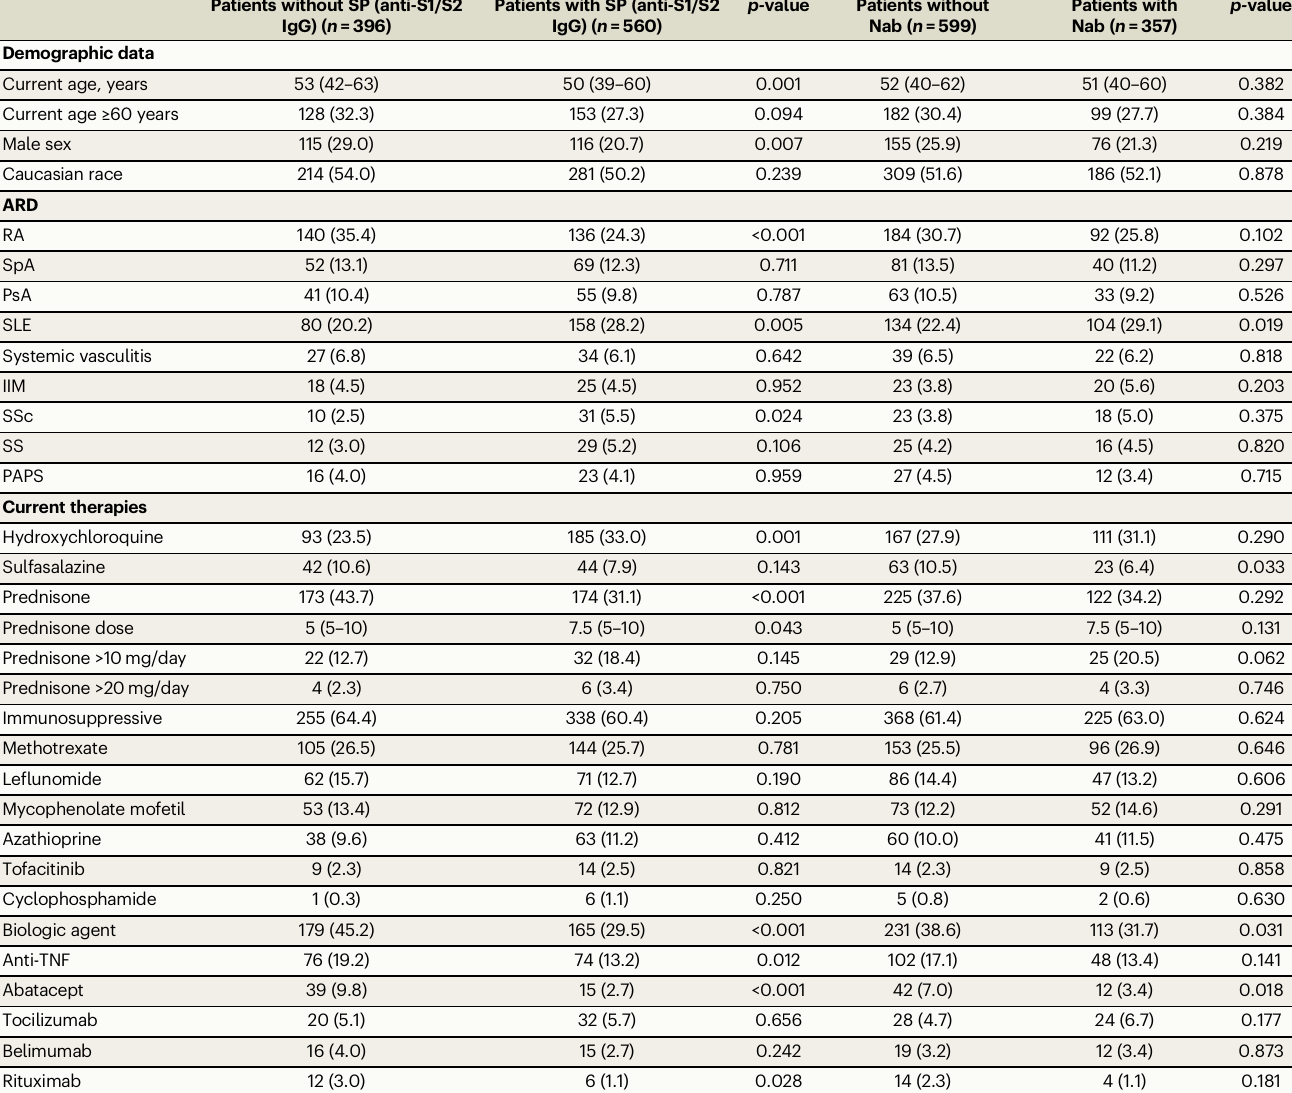
Table 3 | Univariate analyses of characteristics of autoimmune rheumatic diseases (ARD) patients without and with ser- opositivity (SP) for anti-SARS-CoV-2 S1/S2 IgG antibodies and without and with neutralizing antibodies (NAbs 6 months after second dose of Sinovac-CoronaVac vaccination (D210) p- value Patients without Patients without SP (anti-S1/S2 Patients with SP (anti-S1/S2 IgG) ( n =396) IgG) ( n =560) Nab ( n